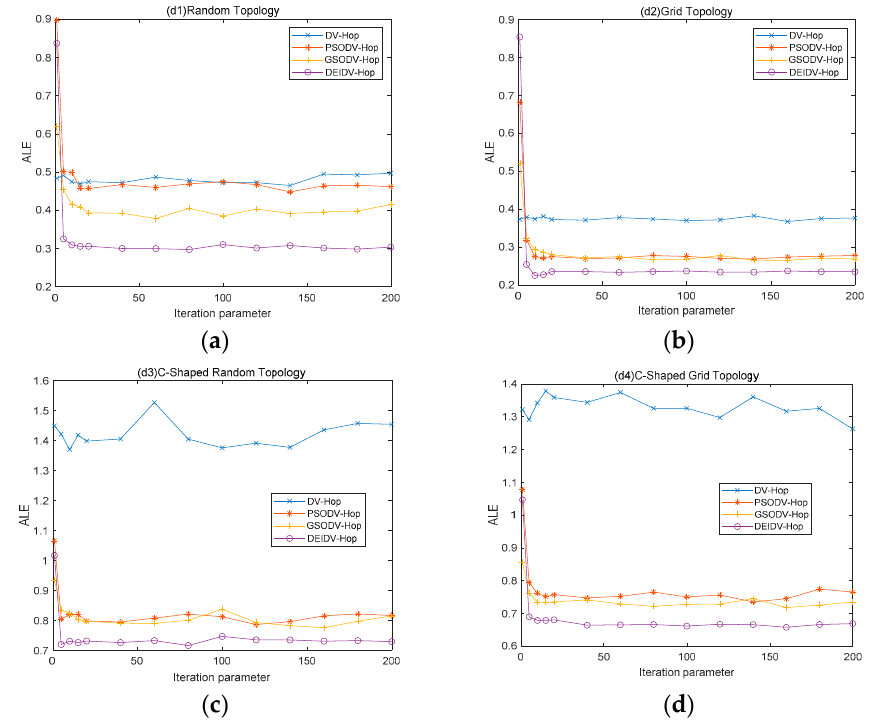
Figure 10. ( a ) E ff ect of the Iteration parameter on ALE in square random topology; ( b ) E ff ect of the Figure 10. ( a ) Effect of the Iteration parameter on ALE in square random to pology ; ( b ) Effect of the Iteration parameter on ALE in a square grid topology; ( c ) E ff ect of the Iteration parameter on ALE in Iteration parameter on ALE in a square grid topology; ( c ) Effect of the Iteration parameter on ALE in C-Shaped random topology; ( d ) E ff ect of the Iteration parameter on ALE in C-Shaped grid C-Shaped random topology; ( d ) Effect of the Iteration parameter on ALE in C-Shaped grid topology.